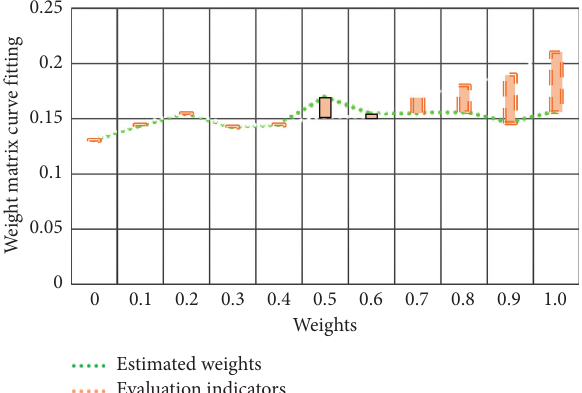
Figure 7: The weight matrix curve fitting diagram of the evaluation index S1 regression